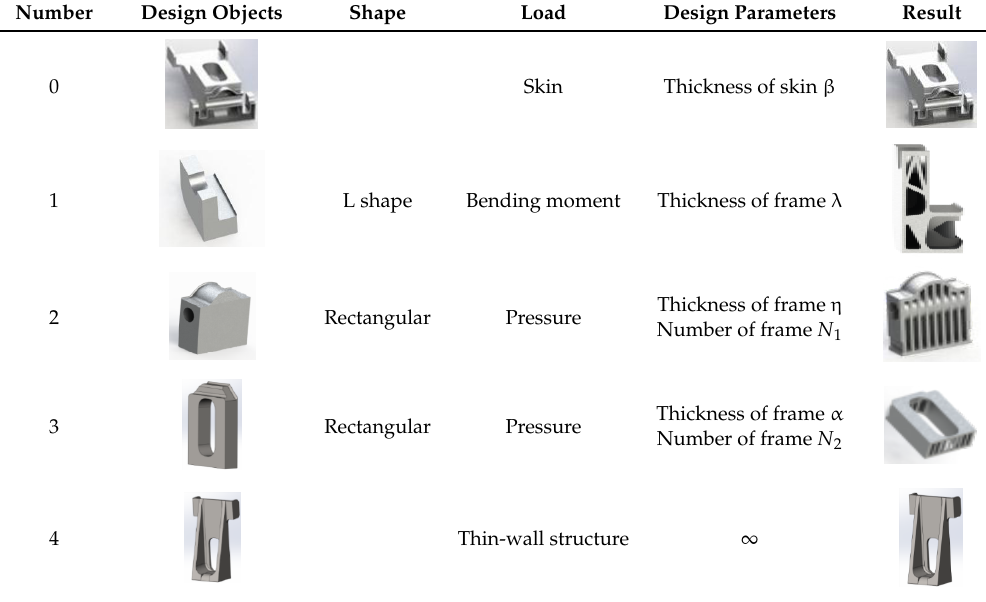
Table 2. Disassembly of stopper.